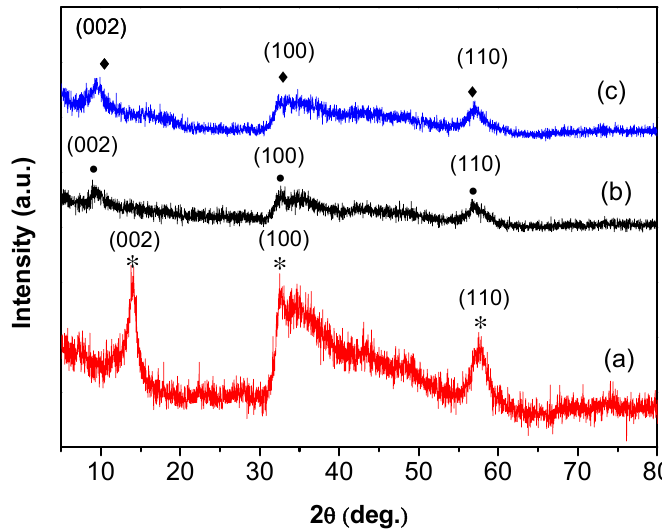
/ 2H-MoS 2 , ( b ) 1T 2 (N), and ( c ) 1T